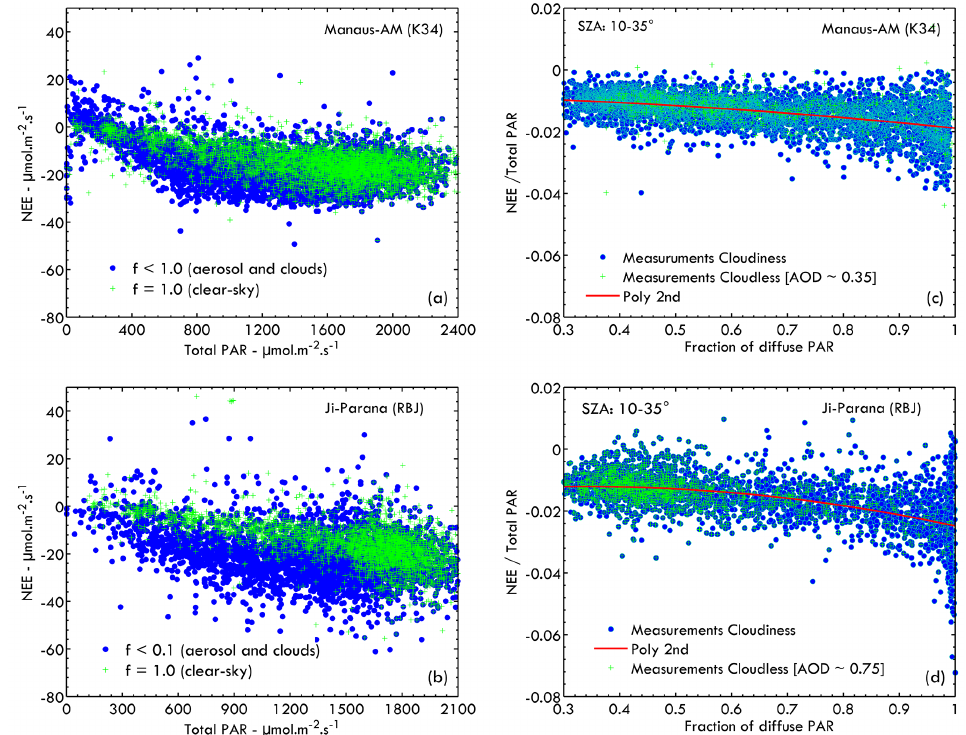
Figure 8. NEE as a function of total downward PAR radiation for measurements between the 08:30 and 17:30LT for the K34 (a) and RBJ (b) sites. Panels (c) and (d) show the LUE of vegetation as a function of the fraction of diffuse PAR at K34 ( R 2 = 0 . 21, p value < 0.001) in Manaus (2000–2009) (c) and RBJ ( R 2 = 0 . 30, p value < 0.001) in Ji-Parana